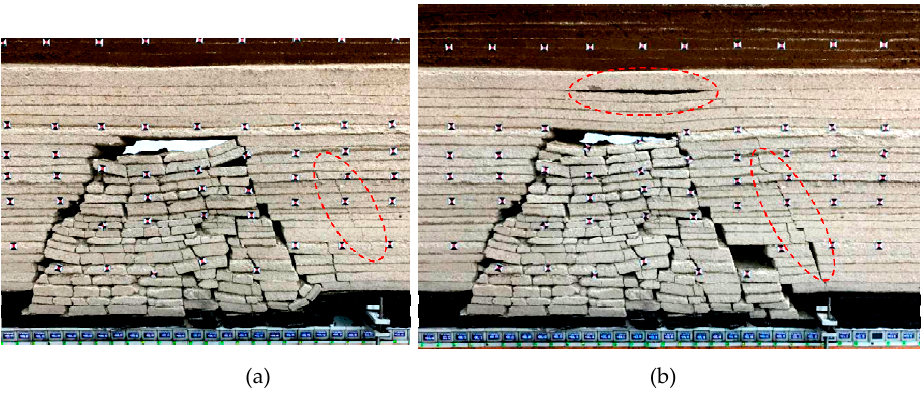
Figure 23. Development of overburden pre-fracture: (a) advanced to 78 m; (b) advanced to 80 m.